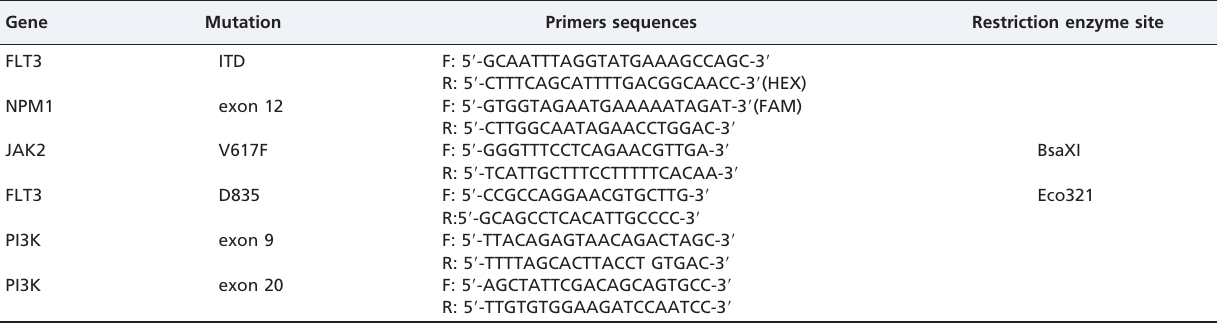
Table 3 - Primer sequences and restriction enzymes Gene Mutation